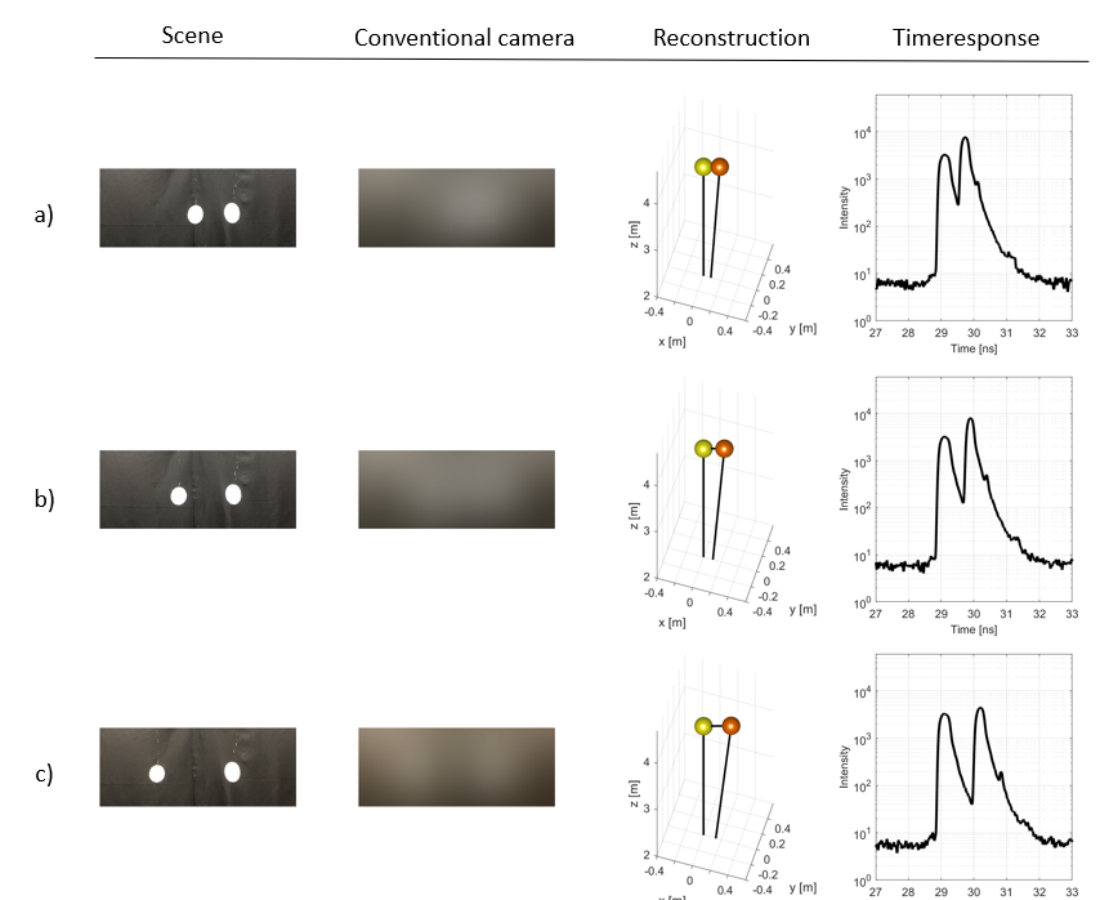
Figure 6. Resolution test using 2 targets ( a ) Circular patches with diameter 3 cm are placed at distance 15 cm from each other. First column shows ground truth image. Simulated image of the scene captured by an imaging system with 20-micron aperture size. Third column shows reconstructed image. Last column is acquired data. In the time response, we can see clearly three peaks. Two first and one second bounce. ( b ) Circular patches with diameter 3 cm are placed at distance 23 cm from each other. ( c ) Circular patches with diameter 3 cm are placed at distance 35 cm from each other. Our SPAD’s dark count rate is 10 photons per second. Coupled with 1 W laser, this dark count rate is negligible in our experiments. After pulsing probability is around 0.1–3% and can also be ignored in our experiments. One way to reduce after pulsing noise is to use fast time-gated SPADs. Gated mode allows a SPAD to be sensitive only during a short gate window of hundreds of picoseconds. The gating window can be moved in time. By progressively moving the active window through the scene in time, one can largely eliminate after